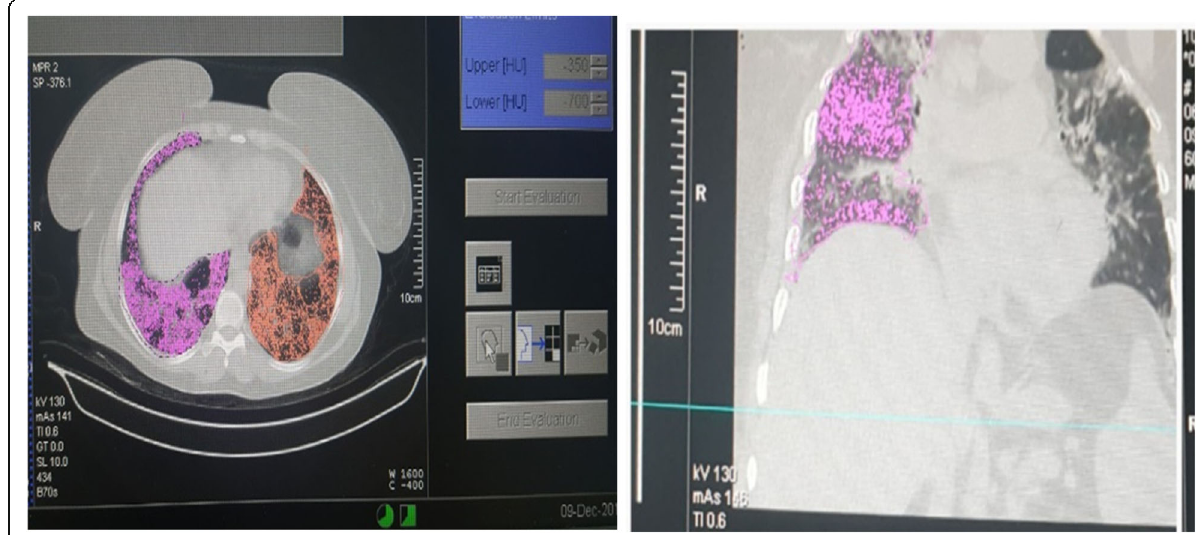
Fig. 1 Volumes of different parenchymal densities were converted into a percentage compared to the total lung